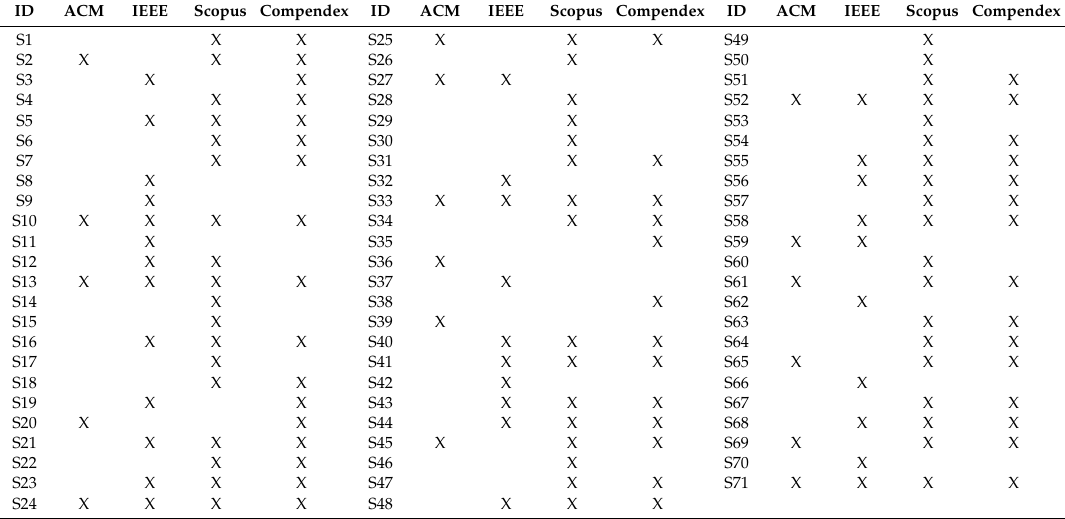
Table A1. Mapping of selected studies returned by selected